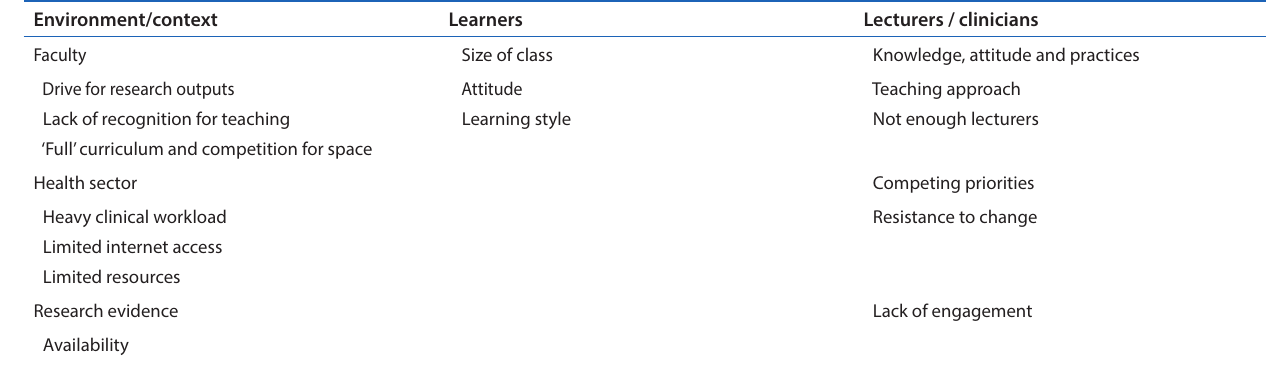
Table 2: Key issues to consider in planning and implementing EBHC teaching and learning